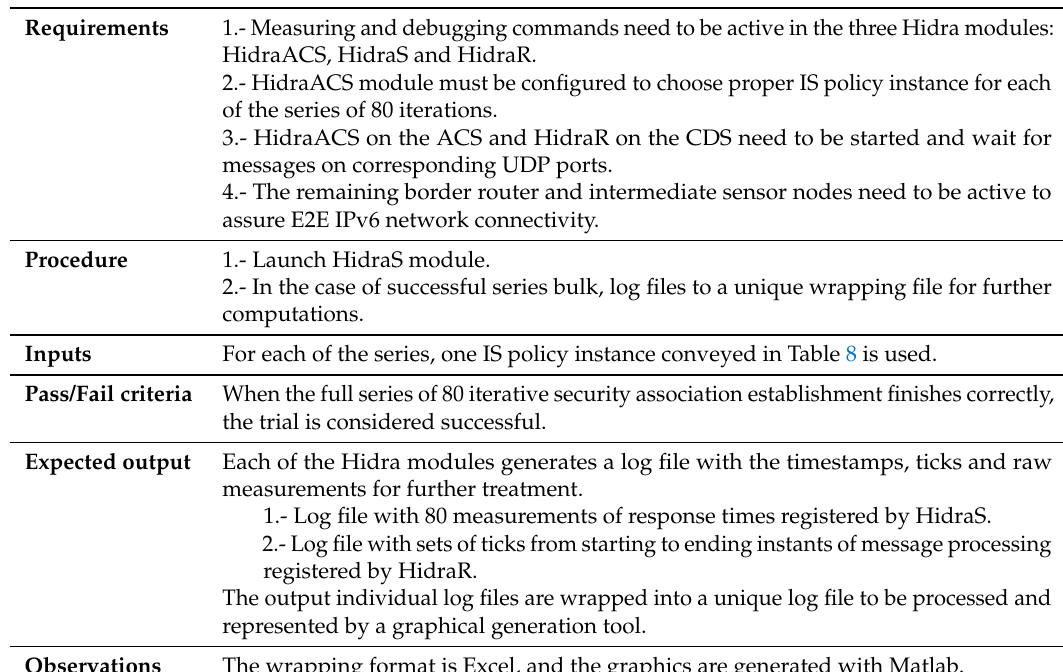
Table 9. Security association establishment trial series launching